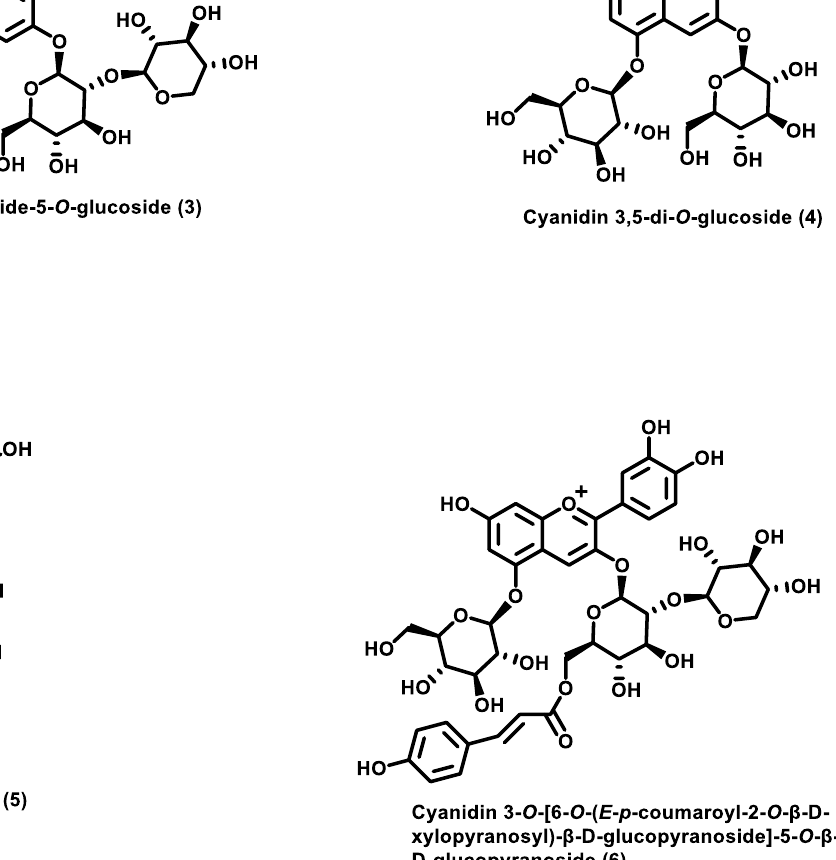
Figure 1. Chemical structure of the anthocyanins of S. nigra and S. canadensis.